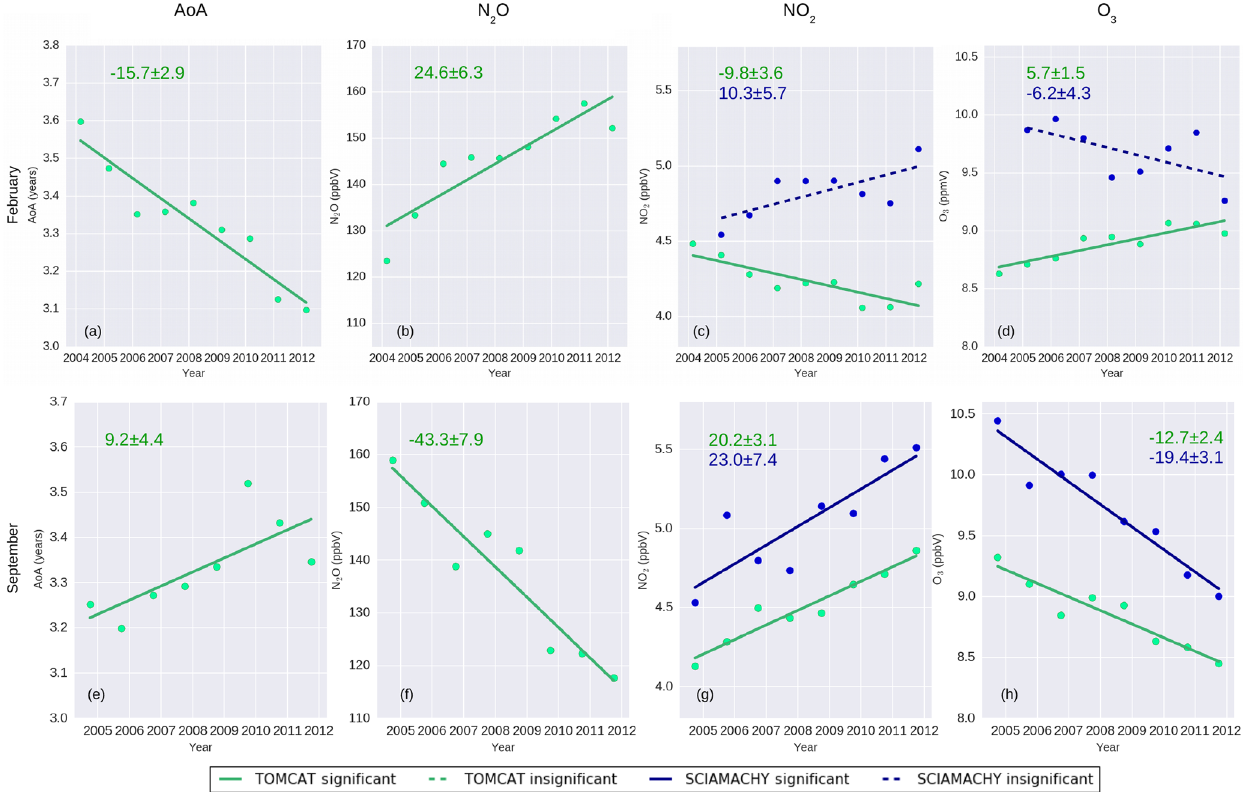
Figure 12. Linear changes in AoA, N 2 O, NO 2 , and O 3 minus QBO effect averaged over (a–d) Februaries 2004–2012 and (e–h) Septembers 2004–2011 in the tropical stratosphere between 30 and 35km altitude. Colour coding indicates the data source: TOMCAT CNTL simulation (green) and SCIAMACHY measurements (dark blue). Colour-coded trend values and their errors (in %decade − 1 ) are shown in each panel. Solid lines indicate statistically significant linear changes at the 2 σ level, dashed lines indicate statistically insignificant